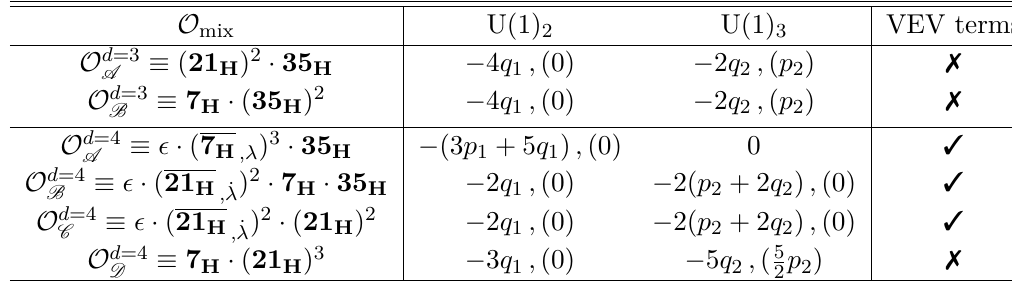
Table 8 . The renormalizable SU(7) Higgs mixing operators and their U(1) 2 , 3 charges. The